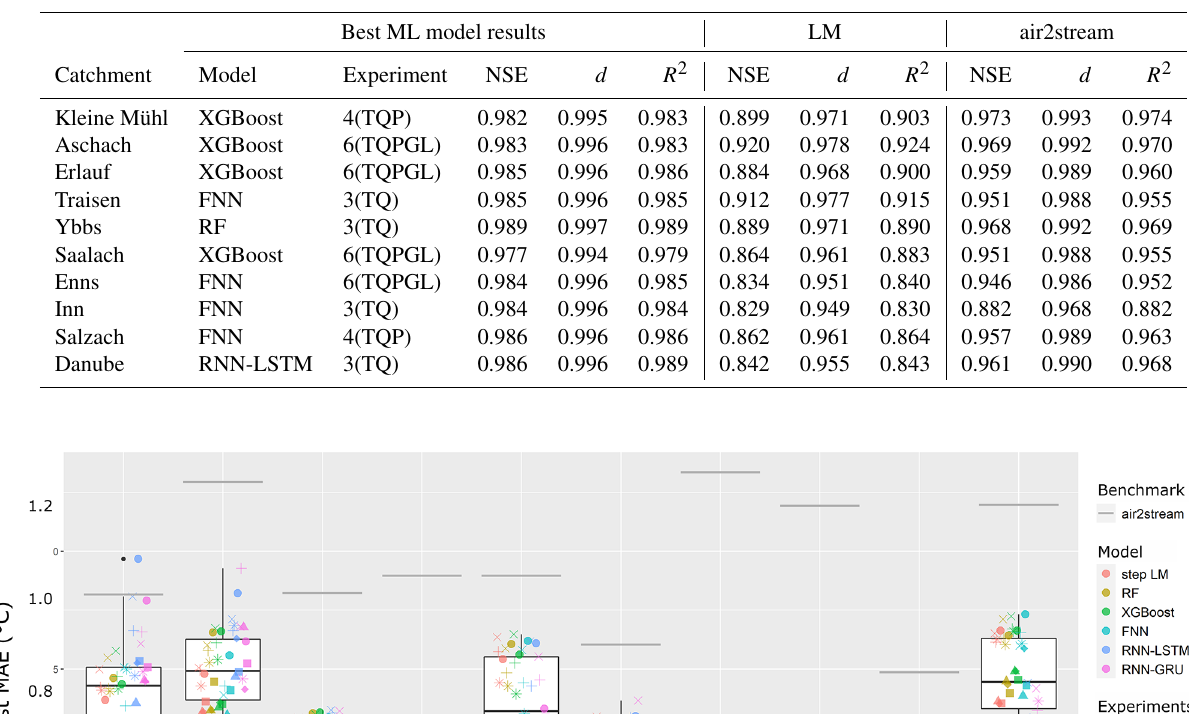
Table A1. Overview of additional model quality criteria of the best machine-learning model for each catchment and the two reference models, consisting of the Nash–Sutcliffe model efficiency coefficient NSE, (Nash and Sutcliffe, 1970), the index of agreement d (Willmott, 1981) and the coefficient of determination R 2 . The best machine-learning model for each catchment was chosen by comparing validation RMSE values. The shown values all refer to the test time period.